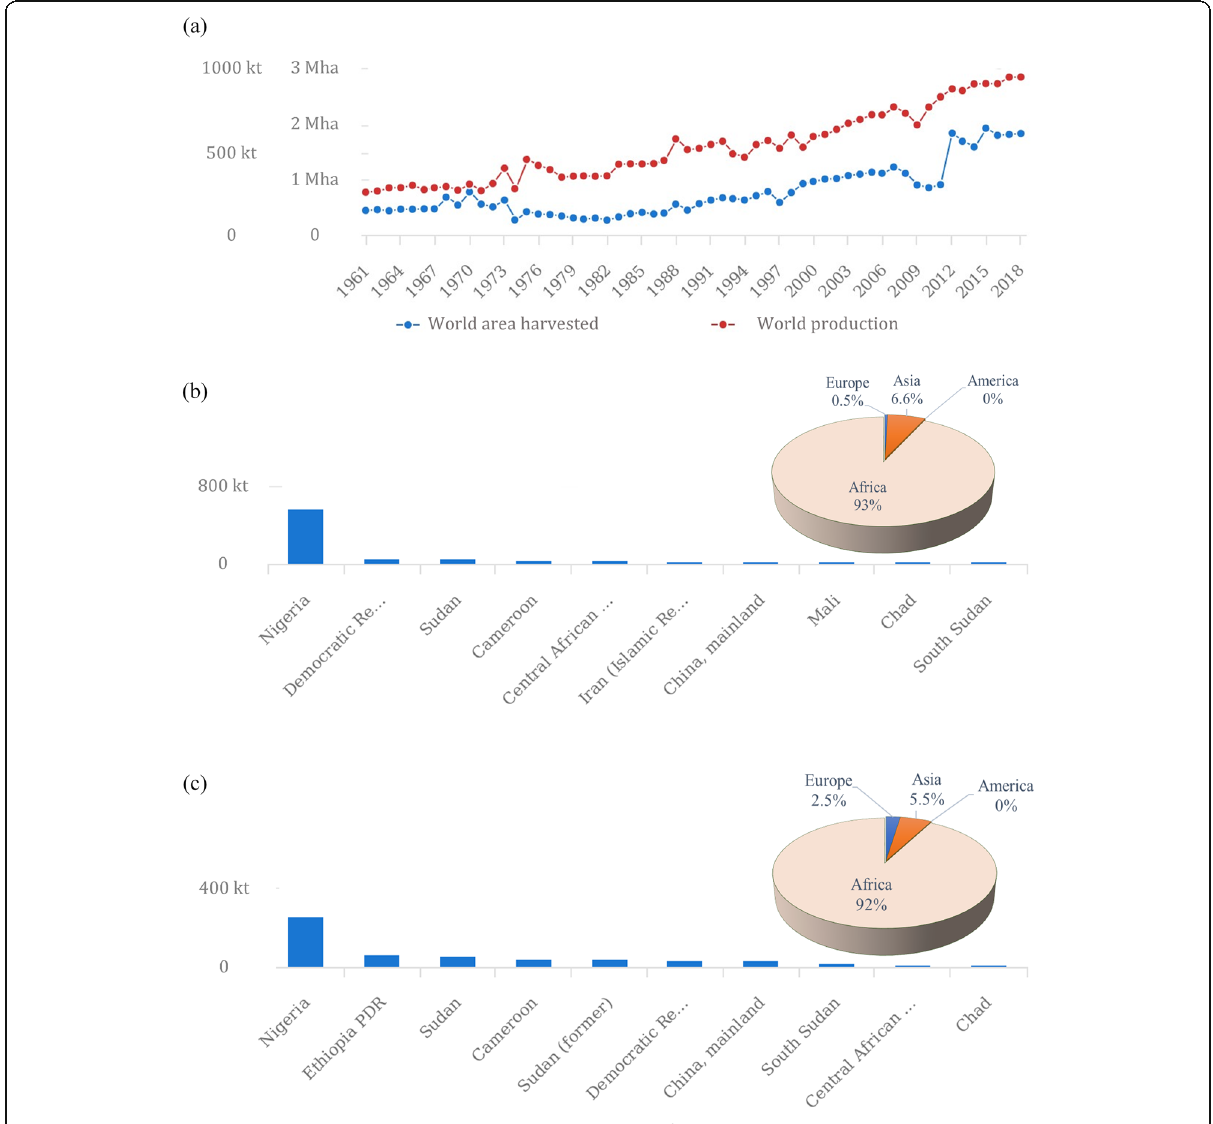
Fig. 1 FAO statistical reports: global production and farmland utilization for melon seed since 1961 ( a ), most recent (2018) total production ( b ), and average production from 1961 ( c ) sorted by region alongside the top 10